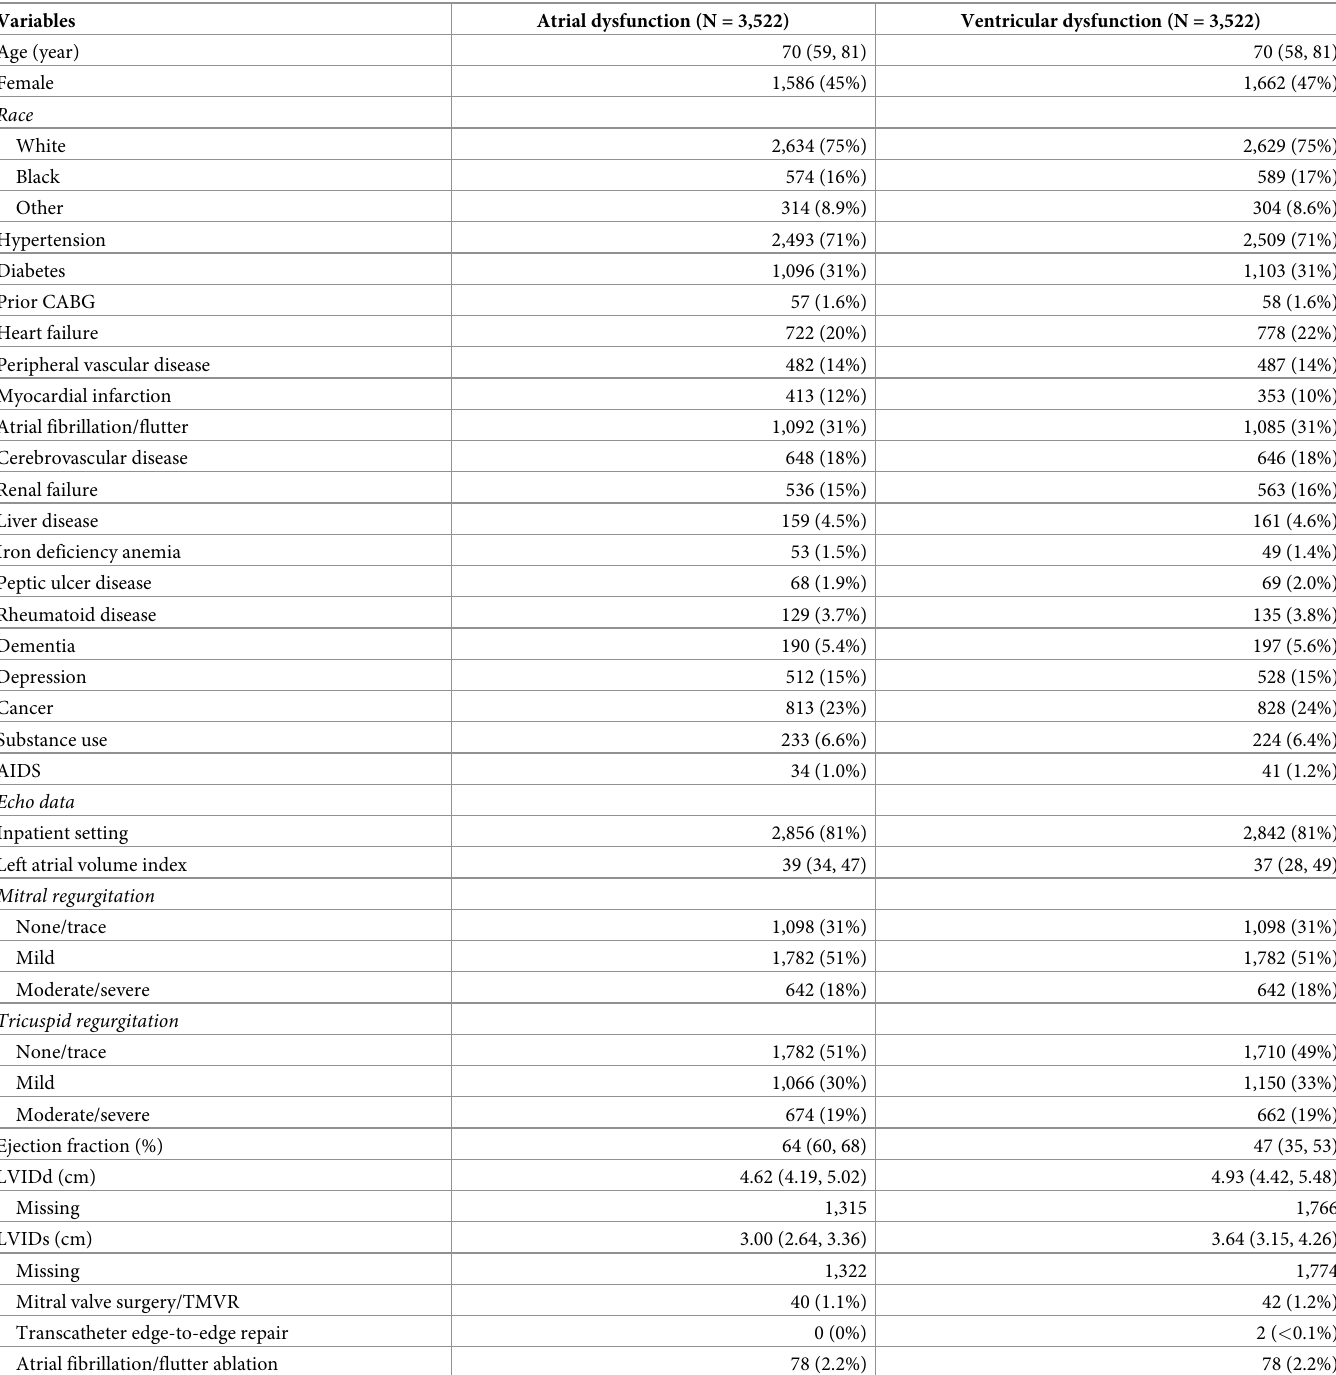
Table 4. Patient characteristics of matched